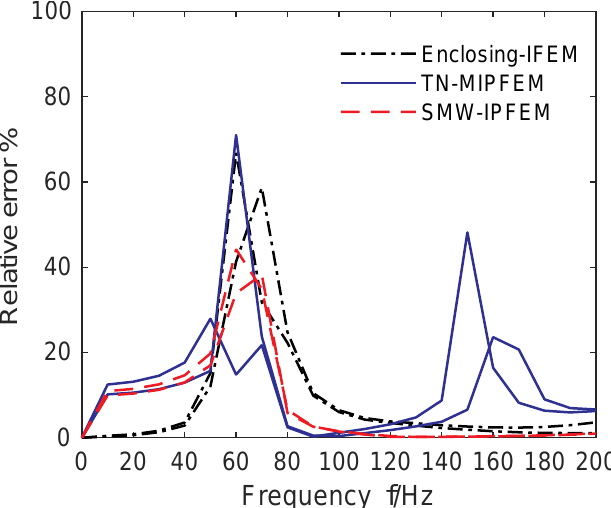
Figure 19. Comparison of the relative errors of different IFEMs for the 3D classical vibro-acoustic coupling model at the receiving point of R2.